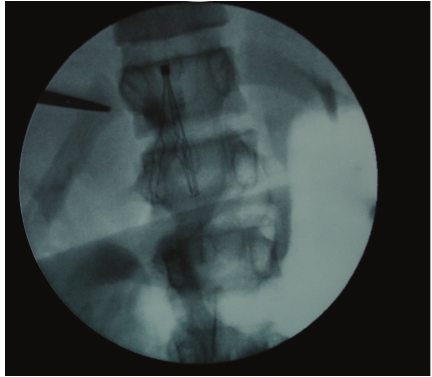
Figure 1: Intraoperative angiography showing inferior vena cava (IVC) filter placement.